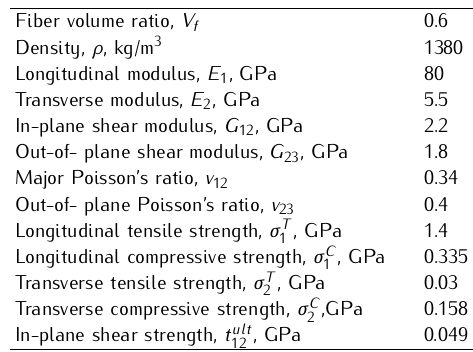
Table 1. Properties of